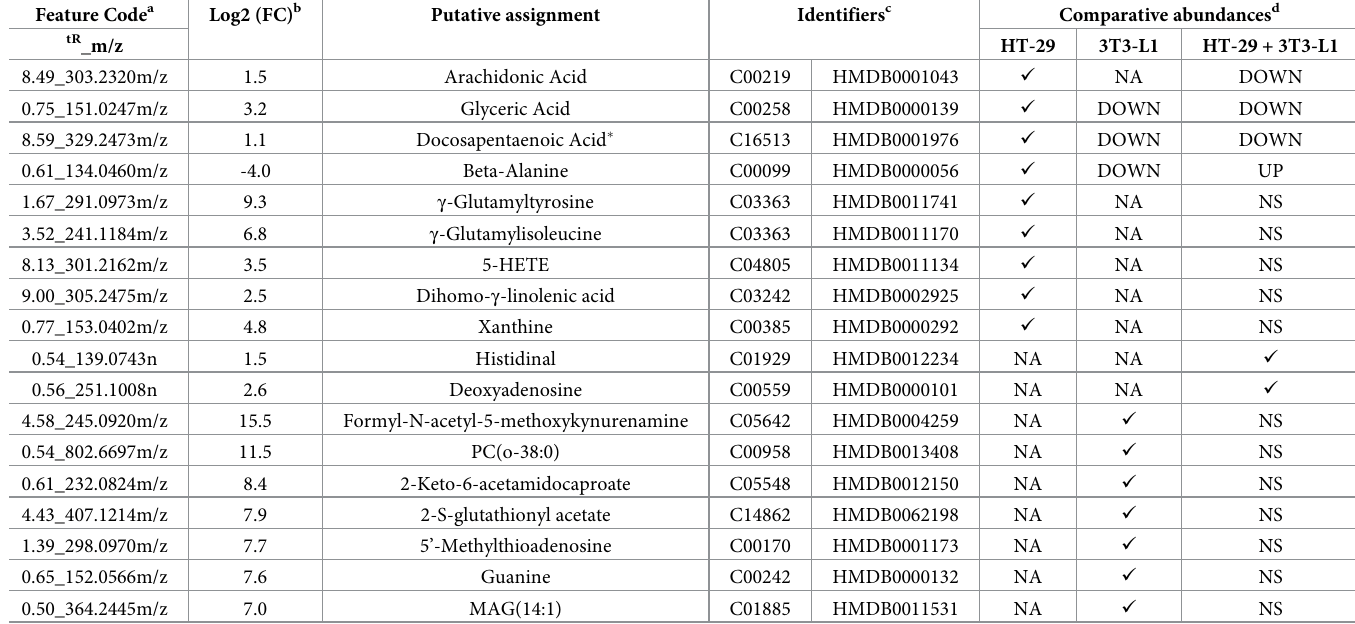
Table 2. Representative secretome from 3D culture or 3D co-cultured spheroids. Feature Code a